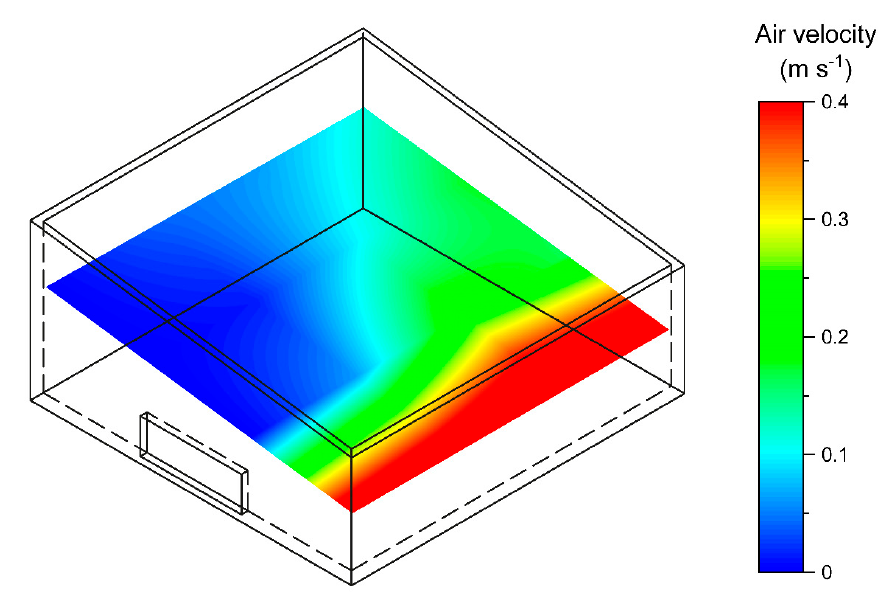
Figure 4. Air velocity across the perforated screen of a small-scale fixed-bed dryer used for cassava processing in Ghana.